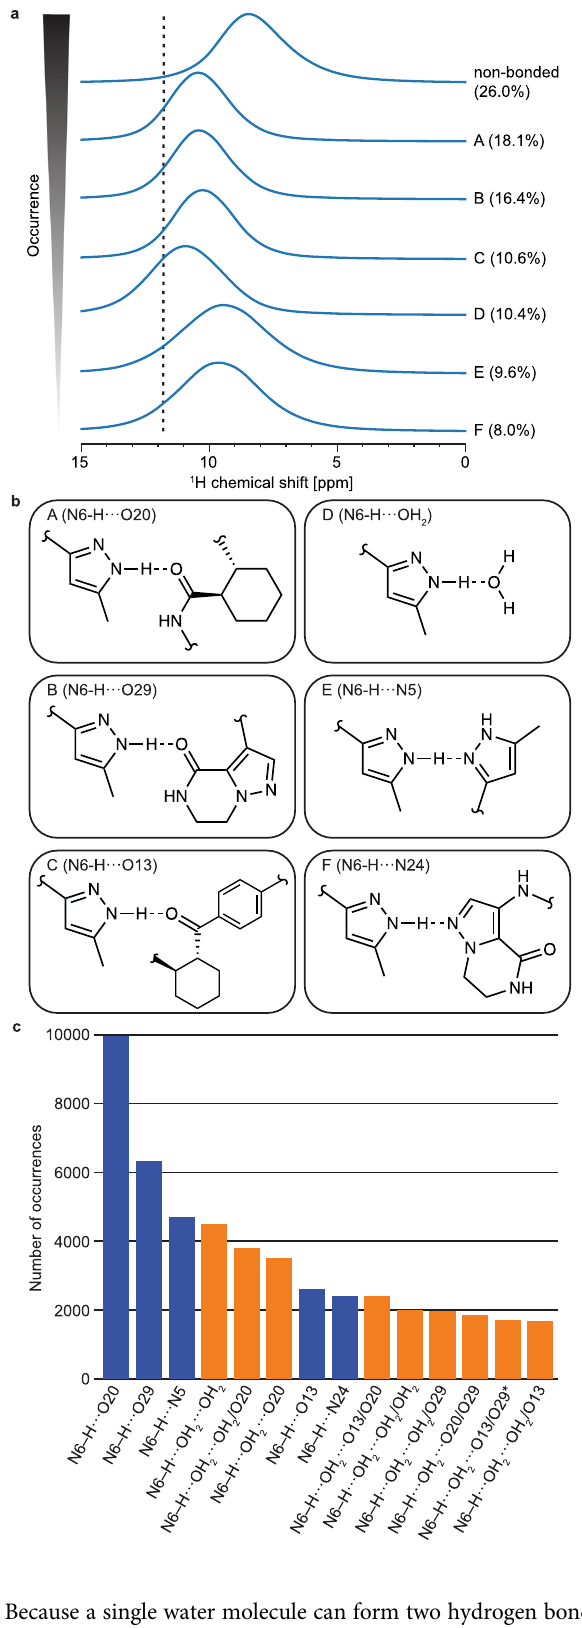
Fig. 4 H-bonding motifs in amorphous AZD5718. a Predicted spectra obtained using the predicted 1 H chemical shifts of the most often occurring N-H bonding motifs involving N6 for 11 evenly spaced snapshots of all amorphous simulations of each water content. The percentages next to the spectra denote the fraction of bonding motifs their corresponding pattern represents, including the instances where no H-bonded neighbour was identi fi ed. The dashed vertical line indicates the experimental shift observed in amorphous 1 and assigned to the proton bound to N6. b Hydrogen bonding motifs associated with the spectra in ( a ). c Number of occurrences of extended H-bonding motifs yielding a predicted chemical shift above 11 ppm for every snapshot of the 4% water simulations. Only the patterns corresponding to the top 75% of all shifts above 11 ppm were selected. The orange bars represent the bonding motifs involving water, and the blue ones correspond to the motifs that do not involve water. Two secondary neighbours from the same molecule are indicated by an asterisk. In ( b ) and ( c ), O n indicates the oxygen atom bonded to carbon